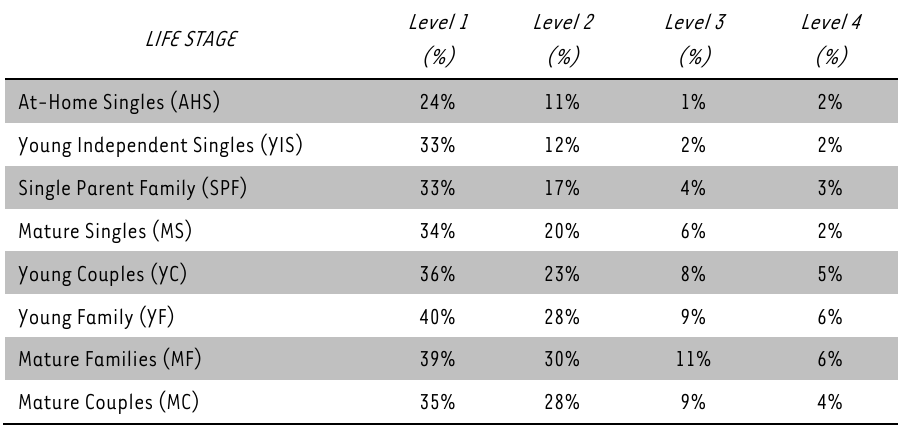
TABLE 2: Product usage rating index